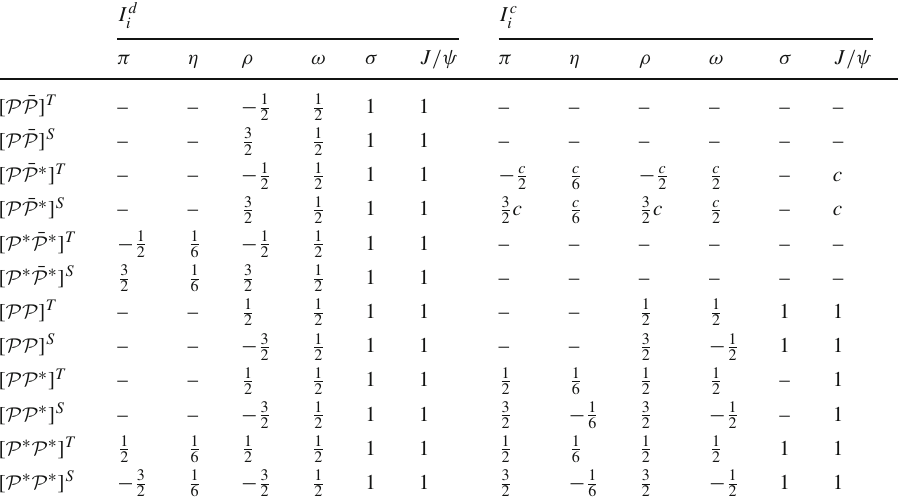
Table 1 The isospin factors I d and I c for direct and cross i diagrams and different exchange